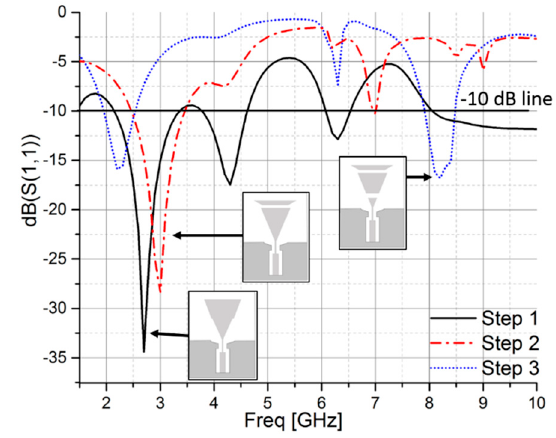
Figure 2. Various steps of the proposed antenna with the corresponding S 11 .